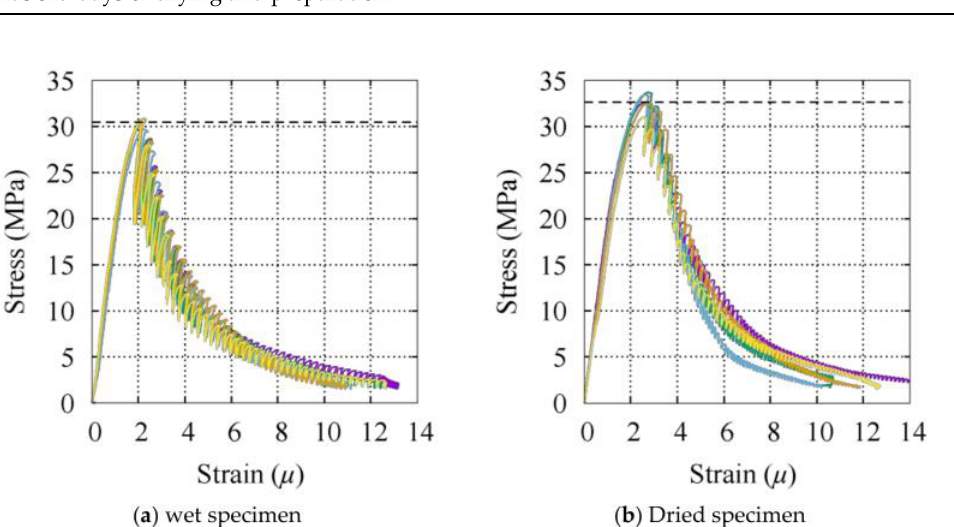
Figure 2. Stress–strain relationships for the concrete in compression. ( a ) Wet specimen, ( b ) dried